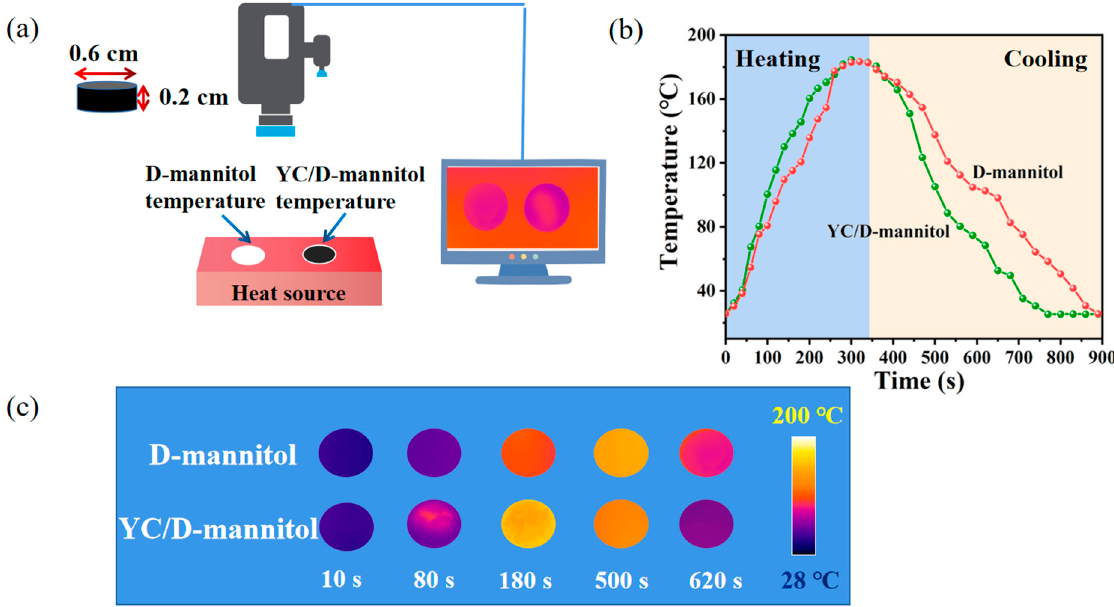
Figure 10. ( a ) Schematic illustration of the thermal response test, ( b ) plots of the temperature evolution, and ( c ) thermal infrared camera images of the YC/D-mannitol during the heat recovery process.